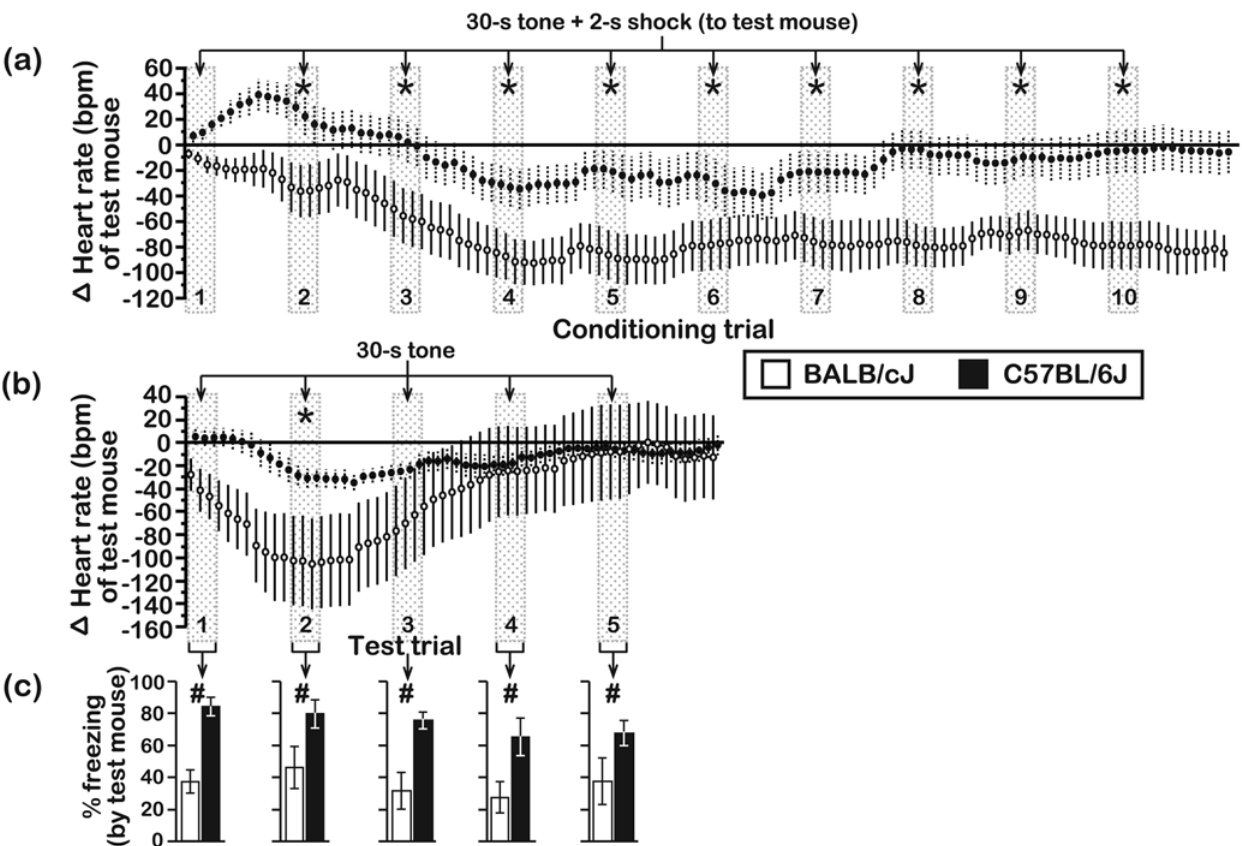
Figure 8. Heart rate changes of mice during direct conditioning with the CS-UCS and testing with the CS-only. HR was measured during (a) the first and second conditioning session in mice that directly received the paired CS-UCS, and during (b) testing, which entailed 5 repeated presentations of the CS-only. HR changes in mice from both strains were similar across the 2 conditioning sessions and therefore pooled for graphical presentation. Each data point represents a 10-s bin. HR is presented as a change ( D ) from the baseline HR of each mouse (see Table 2). (c) Conditioned freezing responses of mice during presentation of the CS-only (N=9 subjects/genotype; age=12–13 wks). Asterisks represent significant (P , 0.05) HR differences between BALB and B6 mice. Numeric symbols represent significant (P , 0.05) differences in freezing between BALB and B6 mice. Behavioral data were scored in duplicate by 2 independent raters and all data are presented as the mean 6 s.e.m. Inter-rater reliability, r p =0.90, d.f.=74. doi:10.1371/journal.pone.0004387.g008 PLoS ONE |